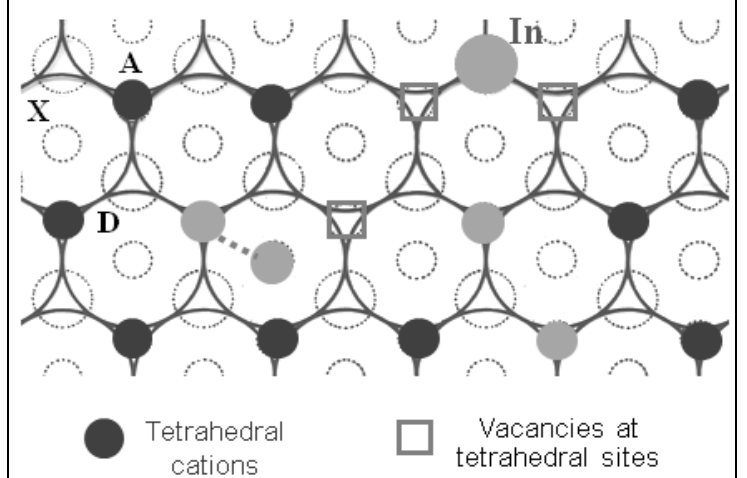
Figure 2. Condensed model sheet [15] figuring out the closest-packed layers of sulphur anions (X) in the crystal structure of ―tetrahedral sulfides‖ where the cations fill half of the available tetrahedral sites (A) in the cubic closest packing of sulfur anions (X), leaving unoccupied the octahedral interstices (D). Insertion situations of indium are